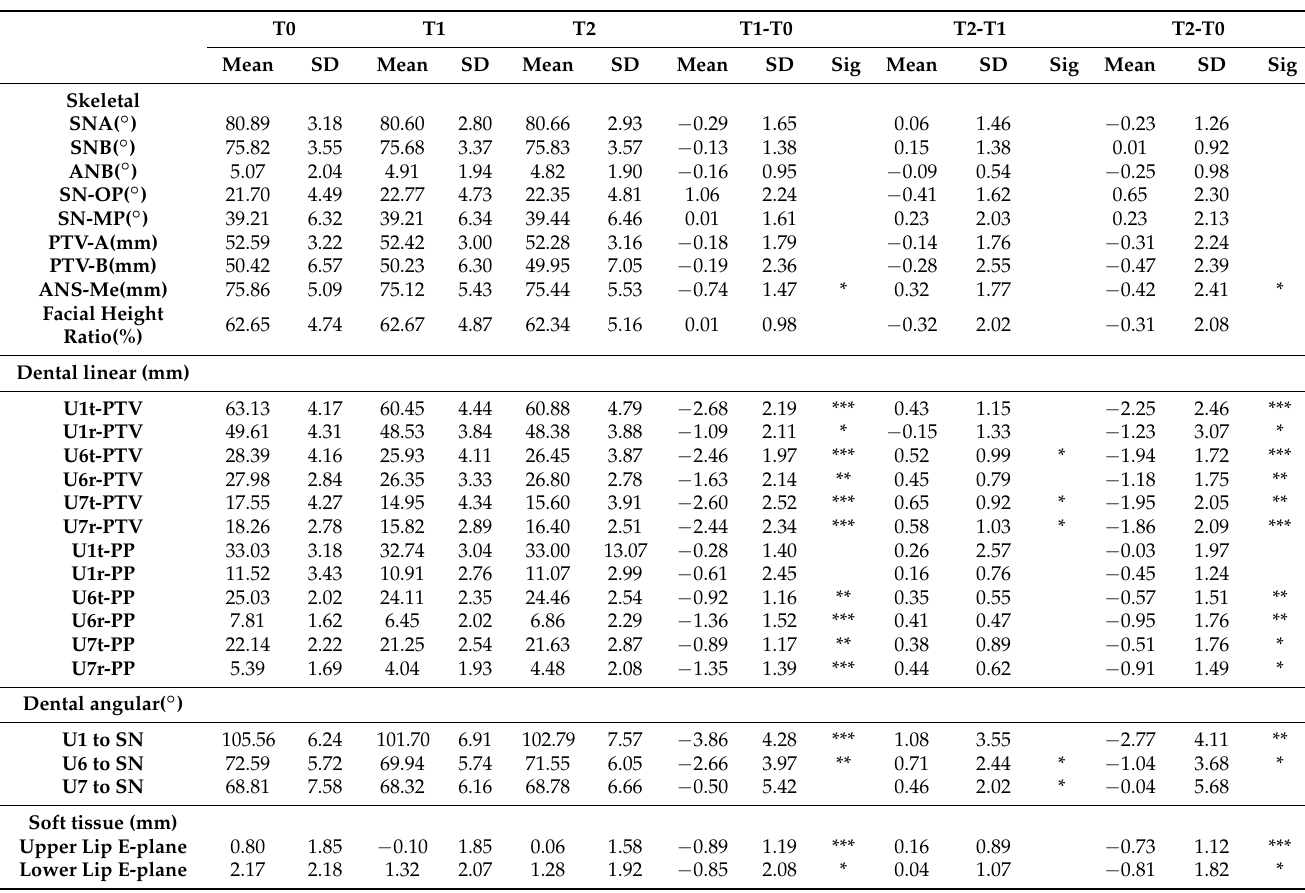
Table 3. Descriptive statistics of cephalometric measurements at pretreatment, post-treatment, postre- tention, pretreatment to post-treatment (T1-T0), post-treatment to postretention (T2-T1) and pretreat- ment to postretention (T2-T0) of maxillary arch distalization group.